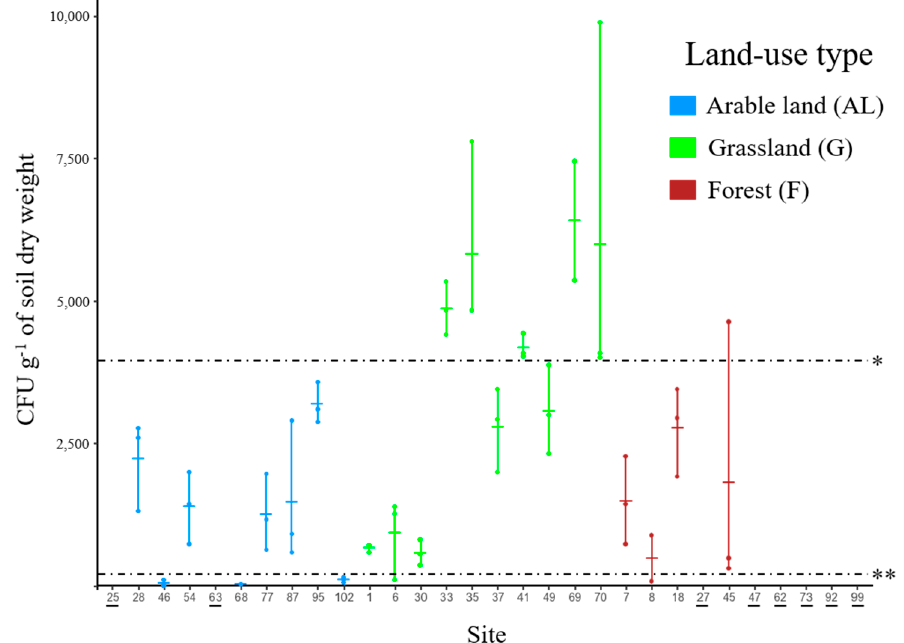
Figure 1. Metarhizium spp. abundance represented as dot plots of colony-forming units (CFU g − 1 of soil dry weight) for different sites (30 NABObio sites). Dots represent values of CFU g − 1 of soil dry weight in each sample per site, and the intersection represents the mean of CFU g − 1 of soil dry weight per site. * Dashed line (4000 CFU g − 1 of soil dry weight) separates the high abundance group from the medium abundance group; ** Dashed line (150 CFU g − 1 of soil dry weight) separates the medium abundance group from the low abundance group) (Table S3). Site numbers where Metarhizium was not detected are underlined.